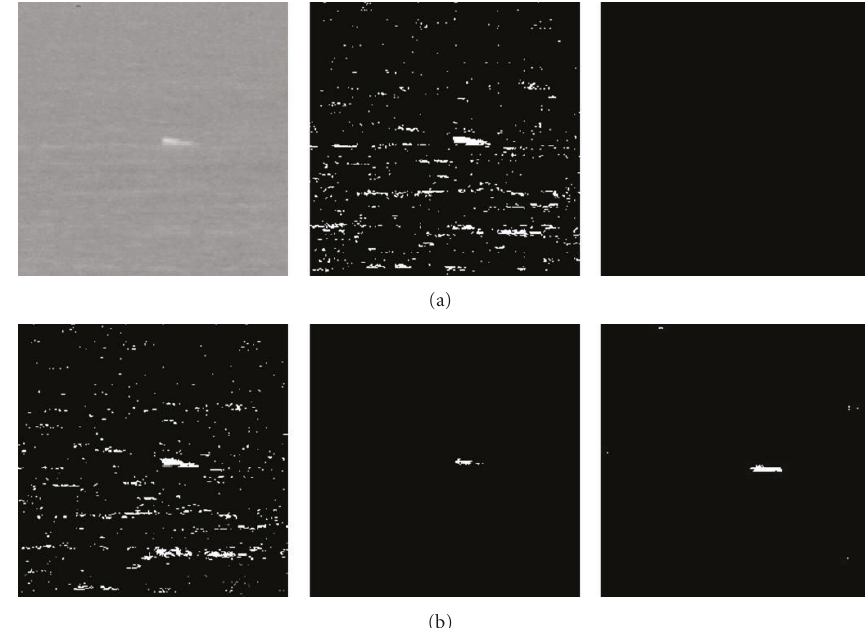
Figure 7: MW05 sequence in the 3–5 μ m band. From left to right, (a): original, mean, gmm. (b): EGMM, ViBe, behaviour subtraction.